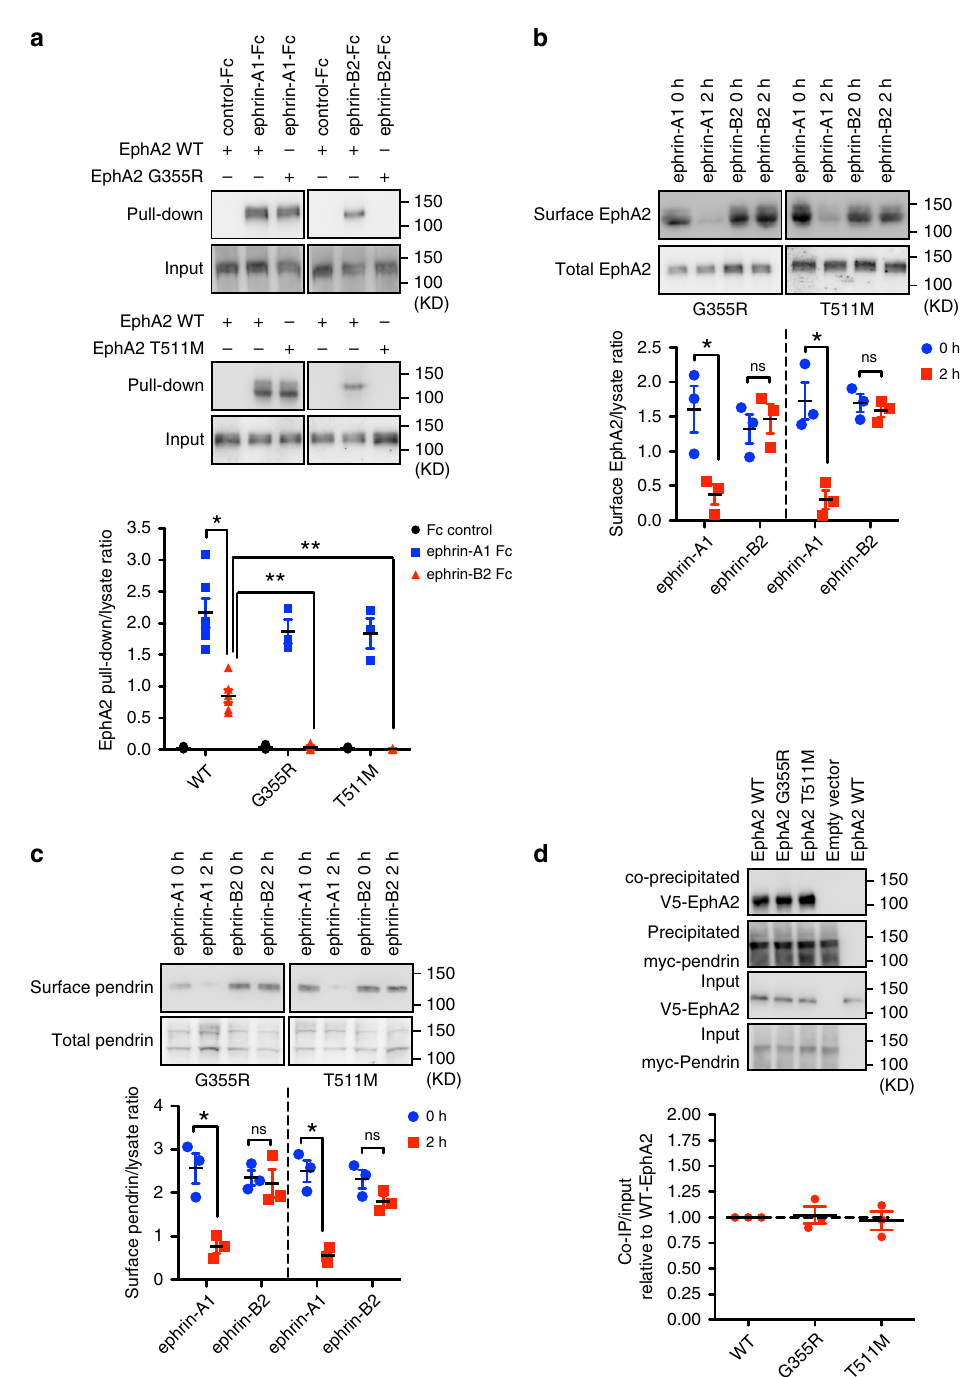
Fig. 7 Identi fi ed EphA2 mutations affect its ability to bind ephrin-B2 but not ephrin-A1. a Pulldown assay using ephrin-A1 or ephrin-B2 Fc fusion proteins with V5-EphA2 and V5-mutated EphA2. Input and pulldown protein with Fc fusion proteins are shown by immunoblot analysis with anti-V5 antibody. Relative amount of pulled down EphA2 is shown below. Mean± SEM.; two-way ANOVA; ** p < 0.01; * p < 0.05; (wt, n = 6; mt, n = 3). b The effect of identi fi ed mutations on ephrin-A1 and ephrin-B2 induced EphA2 internalization. After surface biotinylation, samples were analyzed by western blotting analysis using an anti-V5 antibody. Relative amount of cell surface EphA2 is shown below. Mean ± SEM; one-way ANOVA; * p < 0.05; ( n = 3). c The effect of identi fi ed mutations on ephrin-A1 and ephrin-B2 induced pendrin internalization. After surface biotinylation, samples were analyzed by western blotting analysis using an anti-pendrin antibody. Relative amount of cell surface pendirn is shown below. Mean± SEM; one-way ANOVA; * p < 0.05; ( n = 3). d Immunoprecipitation of mutated EphA2 with pendrin. EphA2 mutations do not affect the binding ability of EphA2 with pendrin. Densitometric quanti fi cations are shown below. Mean ± SEM; ( n = 3). Source data are provided as a Source Data fi